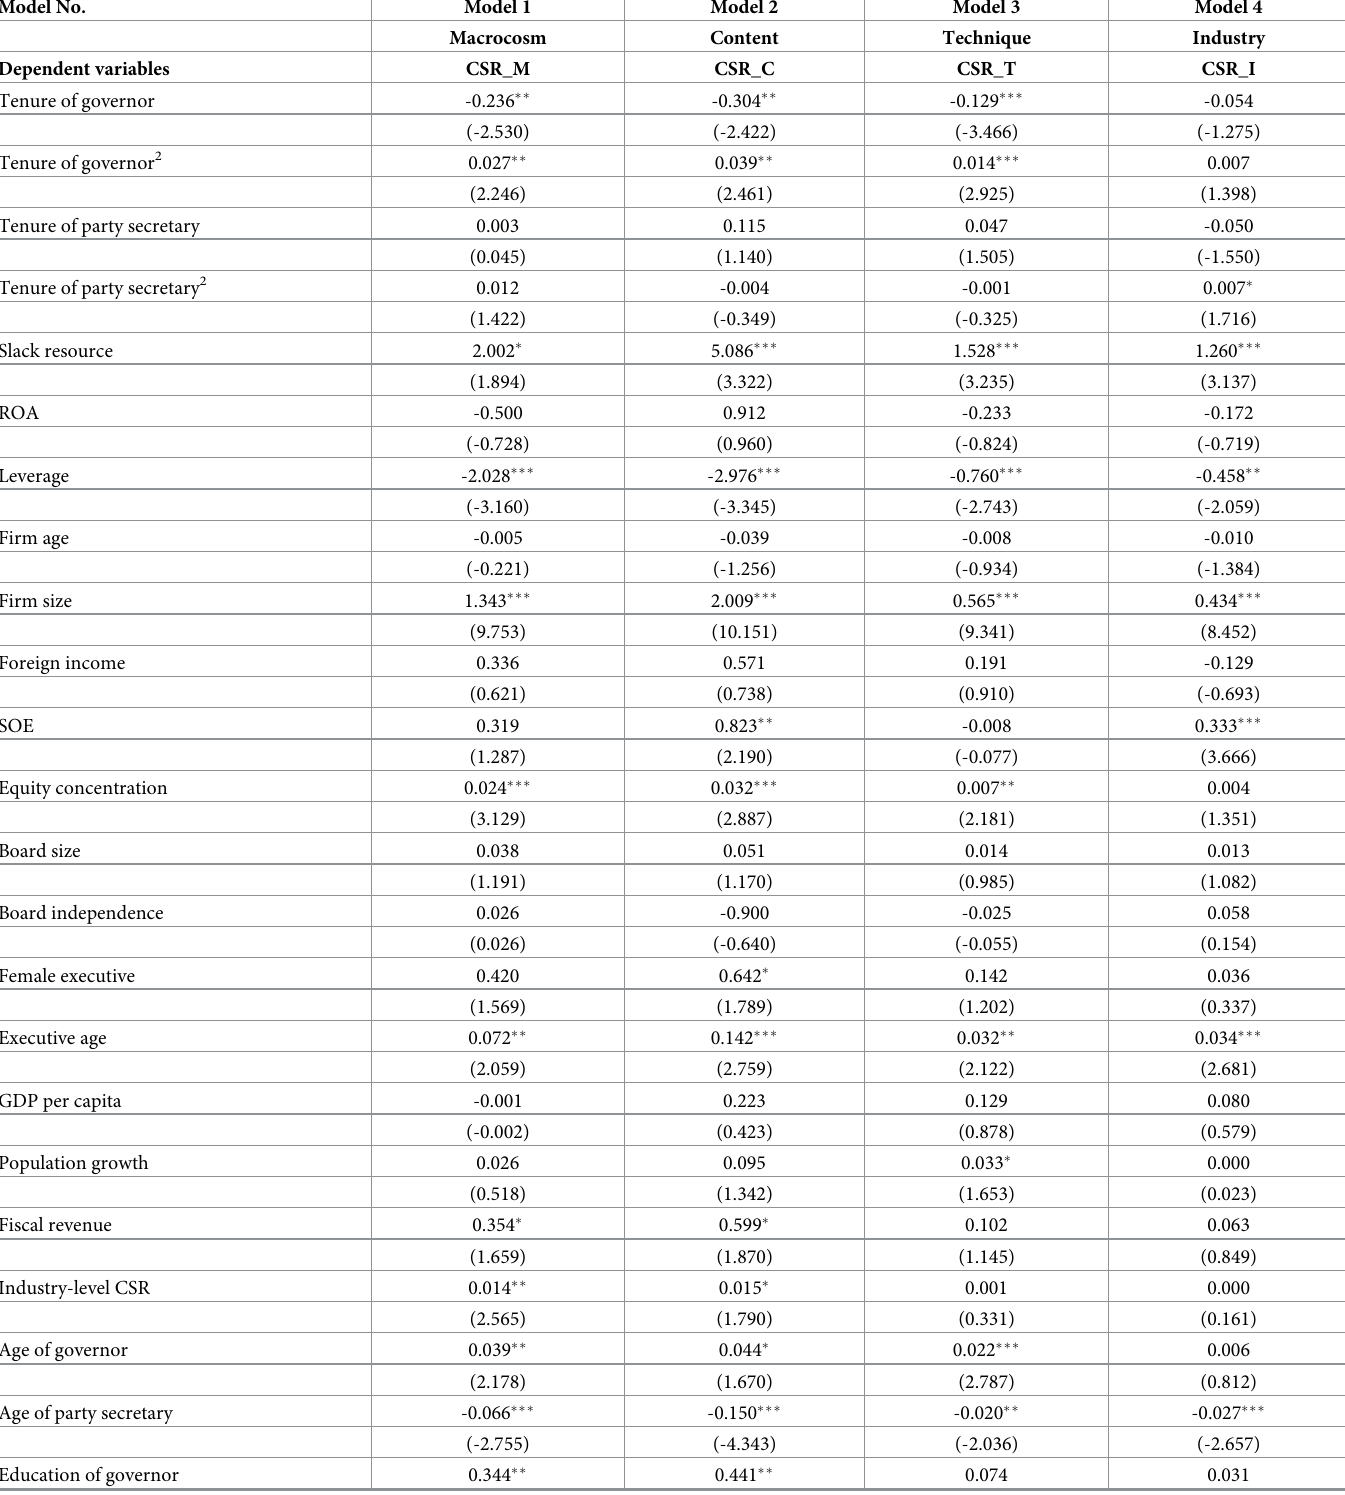
Table 7. The effect of government leaders’ tenure on CSR sub-dimensions. Model